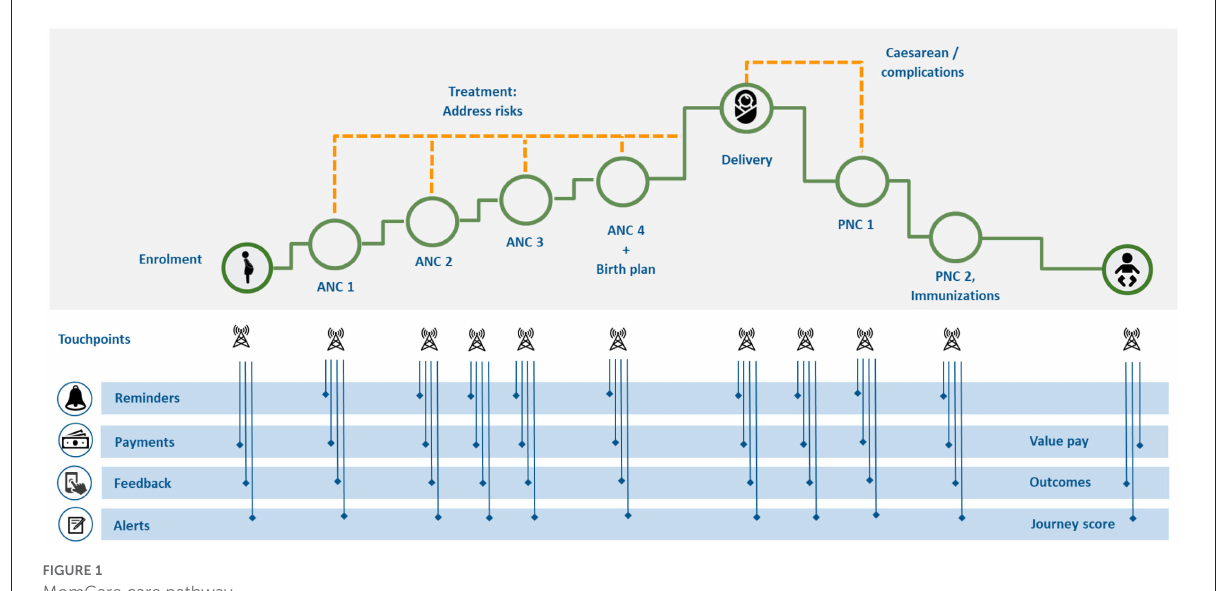
FIGURE1 MomCare care